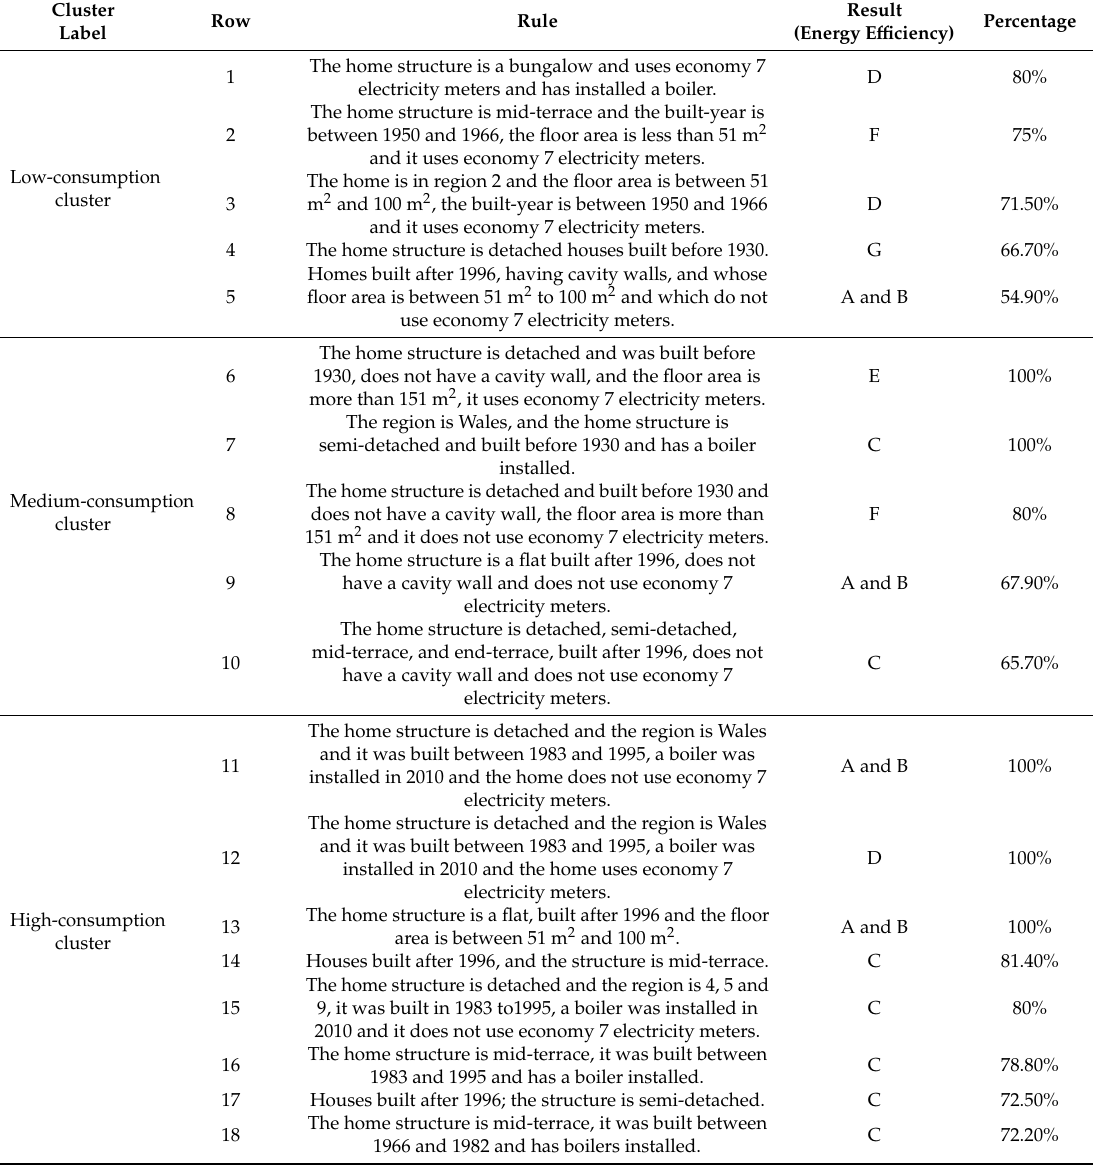
Table 4. The corresponding rules of the C5.0 tree in each cluster separately.